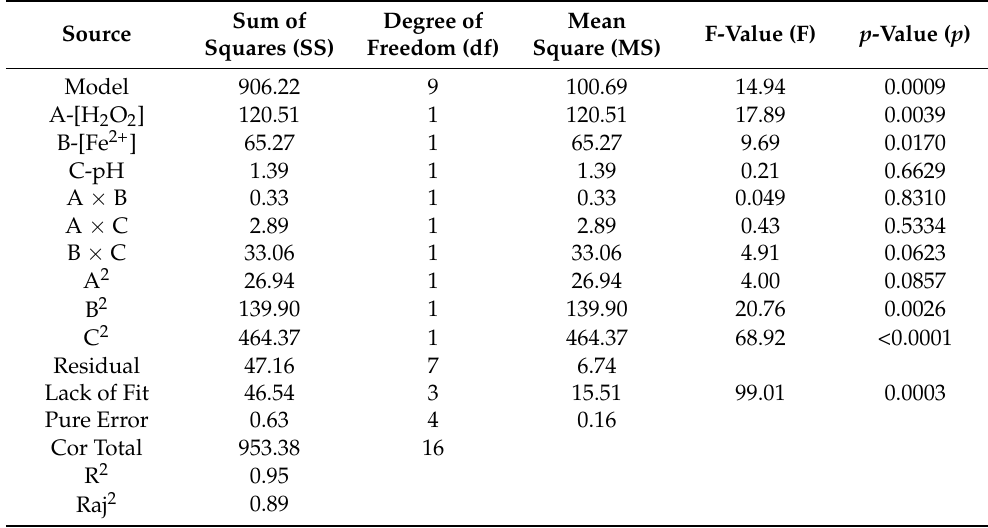
Table 3. Covariance analysis of linear, quadratic and interaction variables of the regression